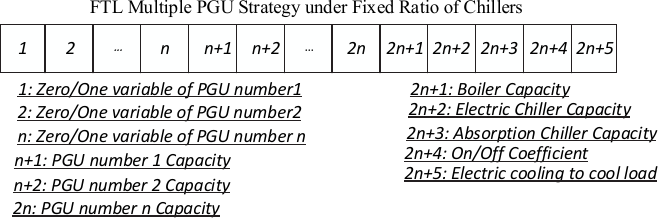
Fig. 2. Chromosomes in different